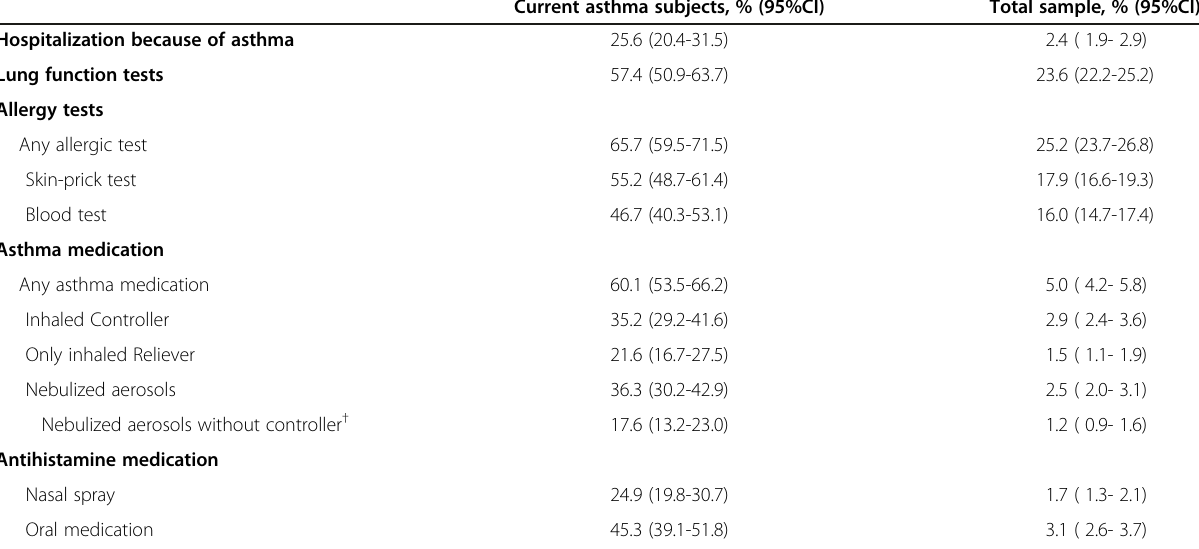
Table 5 Healthcare resources (Medication, diagnosis and hospitalization) for ‘ Current asthma ’ subjects(n = 450) and for total